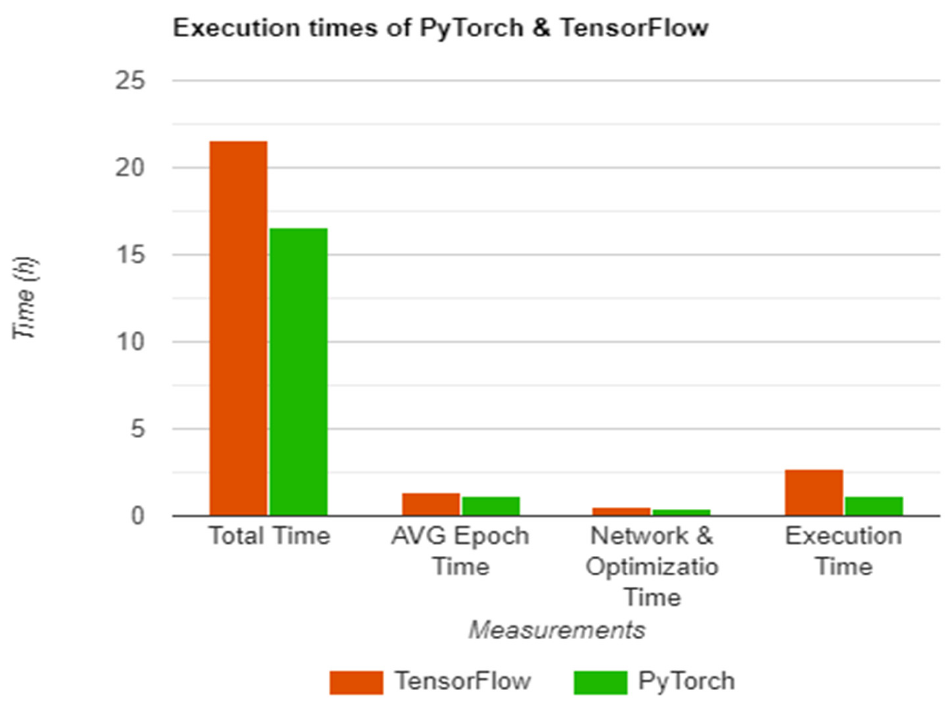
Figure 9. Execution times of PyTorch and TensorFlow chart.